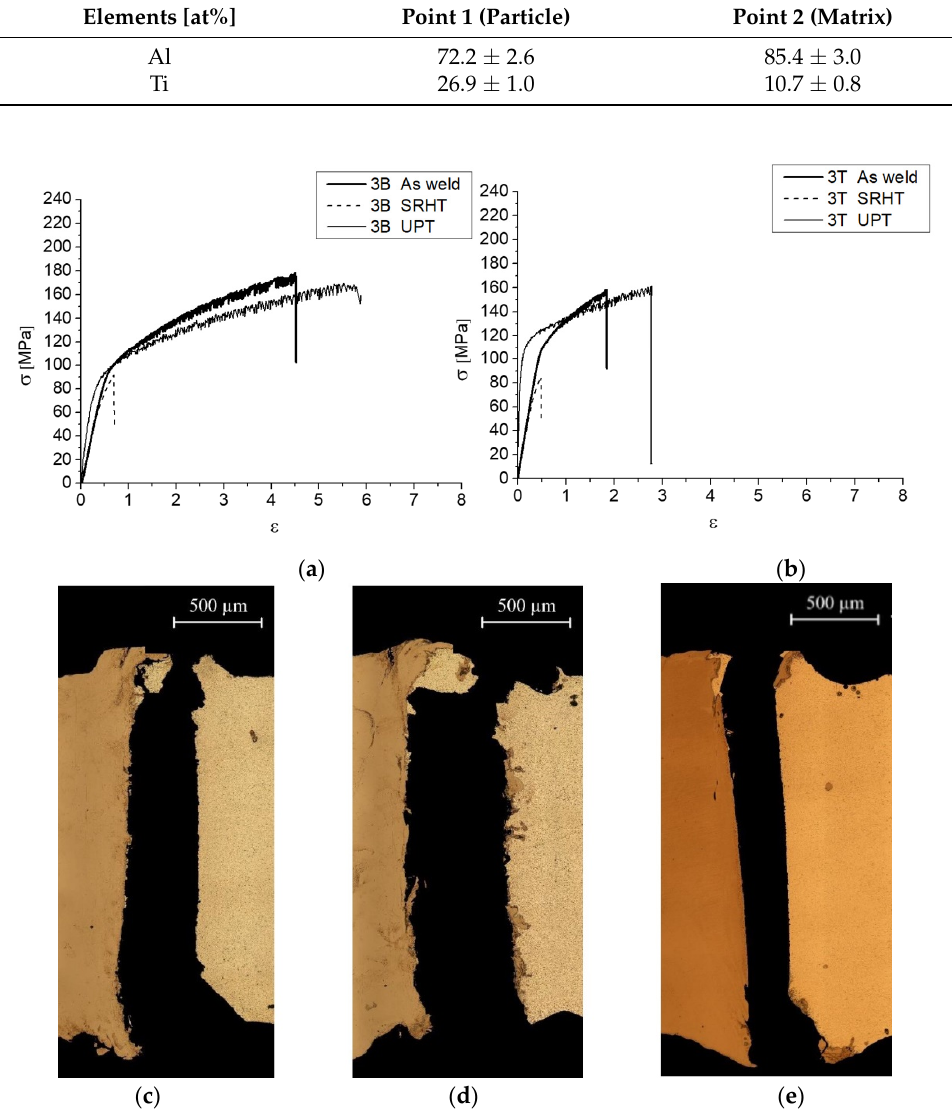
Figure 15. Tensile curves for joints 3B ( a ) and 3T ( b ) as welded, after SRHT and after UPT. Fractured cross section of B sample after tensile test in as welded state ( c ), after UPT ( d ) and after SRHT ( e ).